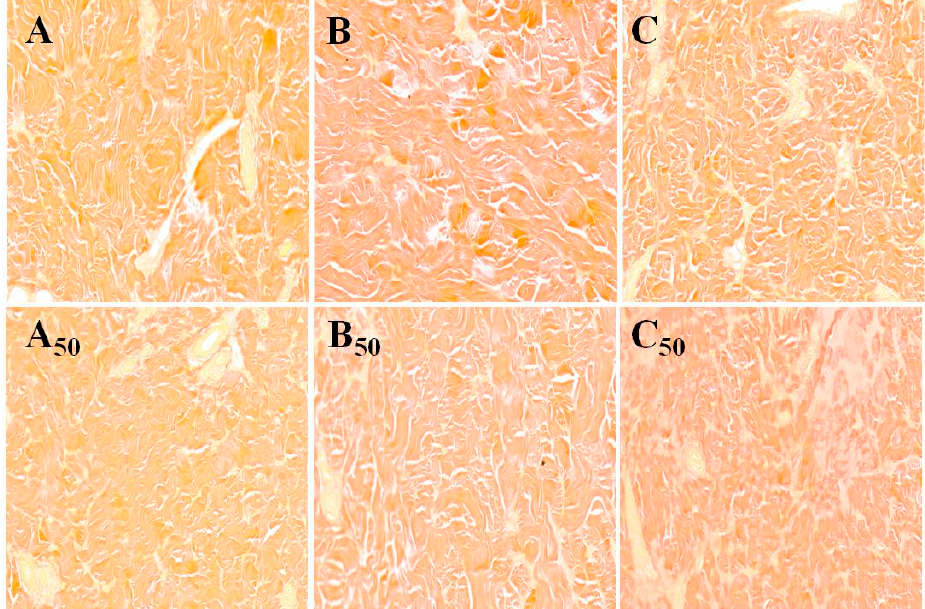
Figure 2. The effect of different treatment conditions (0.1 MPa, 150 MPa, 300 MPa, 0.1 MPa + 50 °C, 150 MPa + 50 °C, 300 MPa + 50 °C) on the ultrastructure of collagen fibers. A, B and C represents magnification × 200 of 0.1 MPa, 150 MPa, and 300 MPa at room temperature, respectively; A 50 , B 50 and C 50 represents magnification × 200 of 0.1 MPa, 150 MPa, and 300 MPa + 50 °C, respectively.